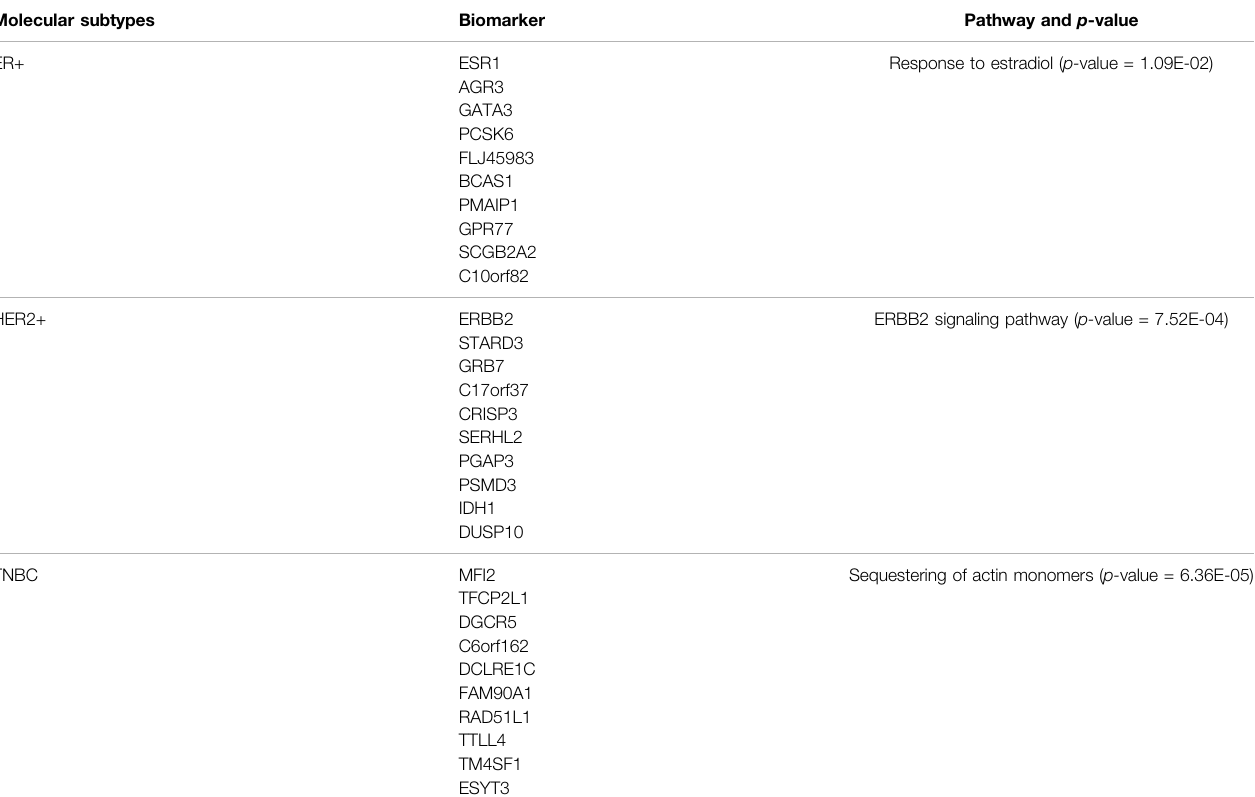
TABLE 4 | Speci fi c biomarkers of each BRCA subtype and their enrichment pathways. The listed biomarkers rank in descending order from high to low speci fi c score. Molecular